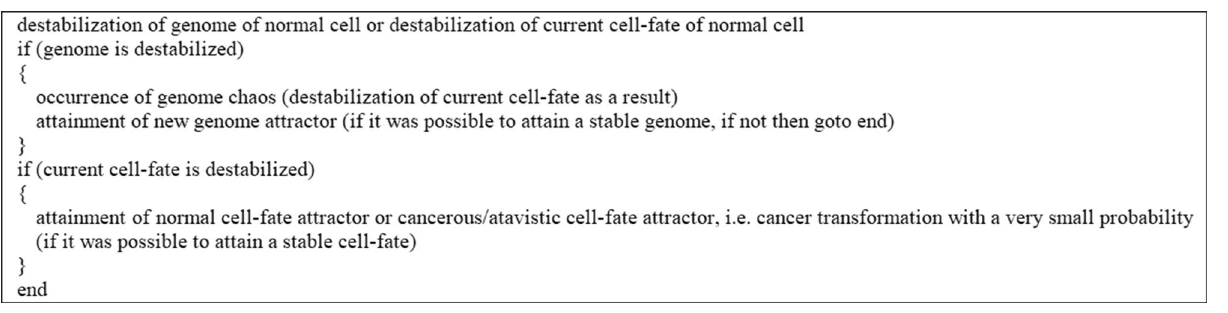
Figure 8. Schema of cancer